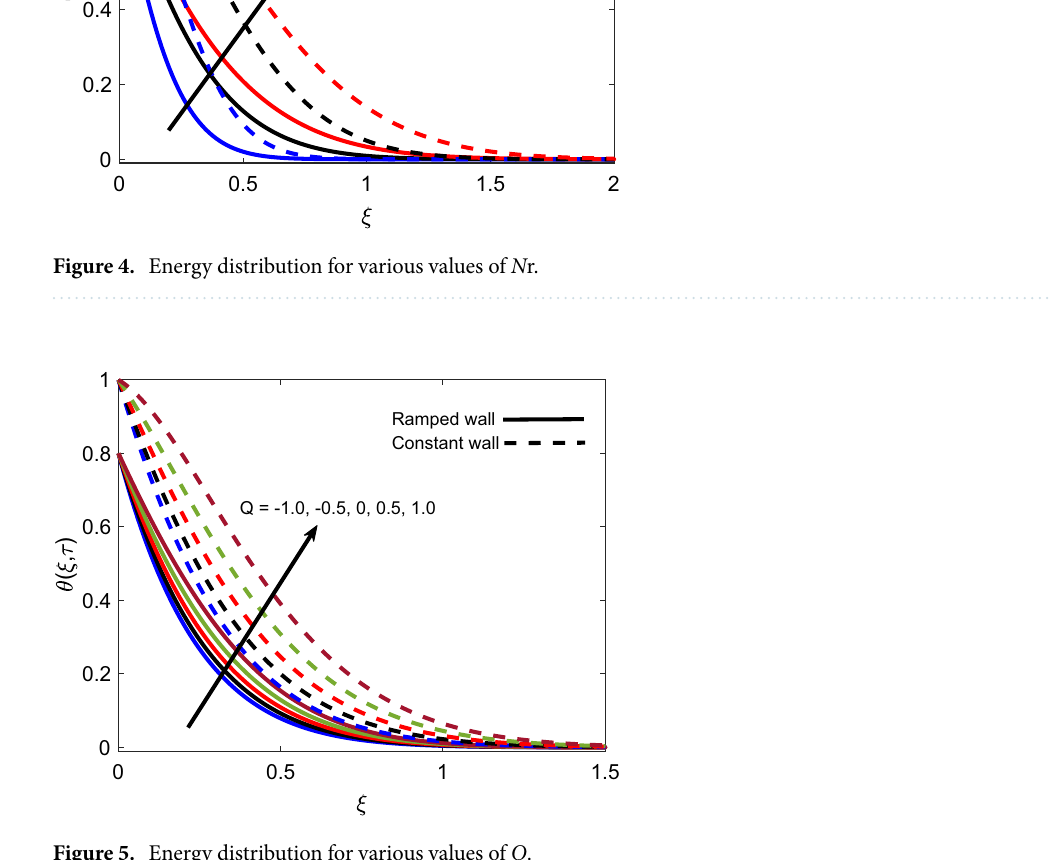
Figure 5. Energy distribution for various values of Q